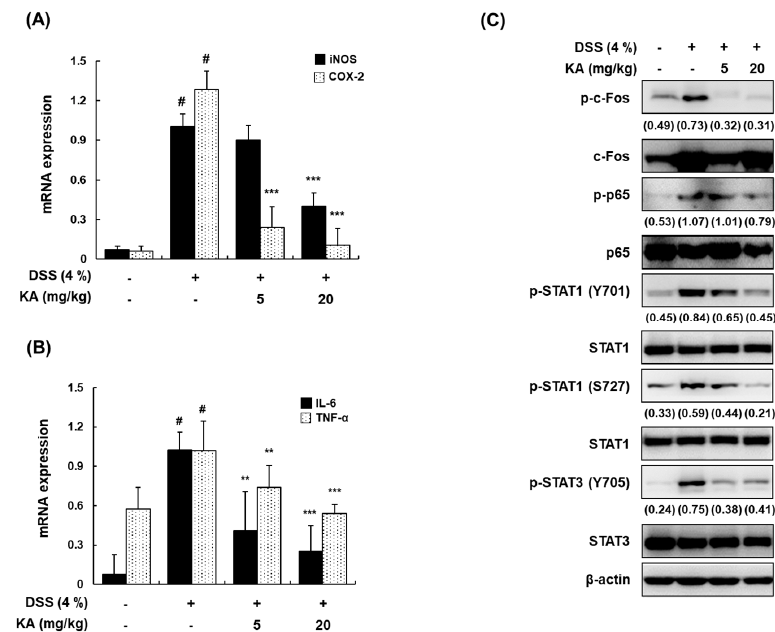
Figure 8. Inhibitory effects of KA on pro-inflammatory mediators and AP-1, NF- κ B, and STAT1/3 activation in DSS-induced colon tissues. ( A , B ) Total RNAs were prepared from DSS-induced colon tissues and analyzed for the mRNA expression of iNOS, COX-2, IL-6, and TNF- α by qRT-PCR. The levels of iNOS, COX-2, IL-6, and TNF- α were adjusted by β -actin expression. Values are the mean ± SDs ( n = 12); # P < 0.05 vs. the vehicle-treated control group; * P < 0.05, ** P < 0.01, *** P < 0.001 vs. the DSS-treated group. ( C ) Colon tissues were homogenized after 7 days of DSS treatment, and whole proteins were prepared for Western blotting to detect the protein expression of p-c-Fos, c-Fos, p-p65, p65, p-STAT1 (Y701), STAT1, p-STAT (S727), p-STAT3 (Y705), and STAT3 antibodies. β -actin was used as an internal control. Values in brackets means the relative density of a representative